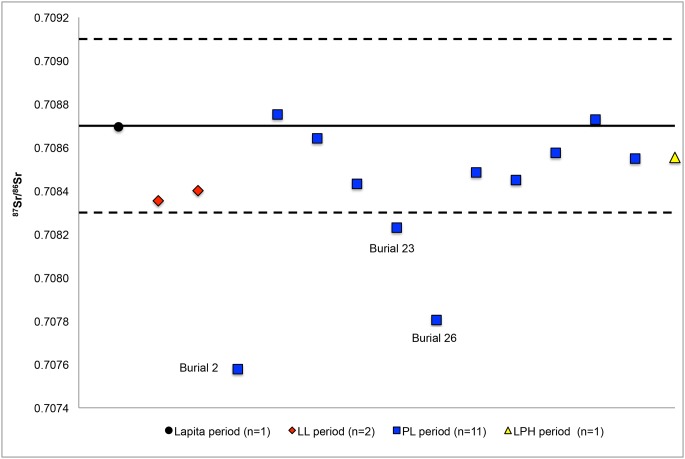
Human 87Sr/86Srenamel ratios plotted in relation to the biologically available average 87Sr/86Srplant ratio of Uripiv.The solid line represents the average 87Sr/86Srplant ratio for Uripiv and the dashed lines delineate±2 SD from this mean.